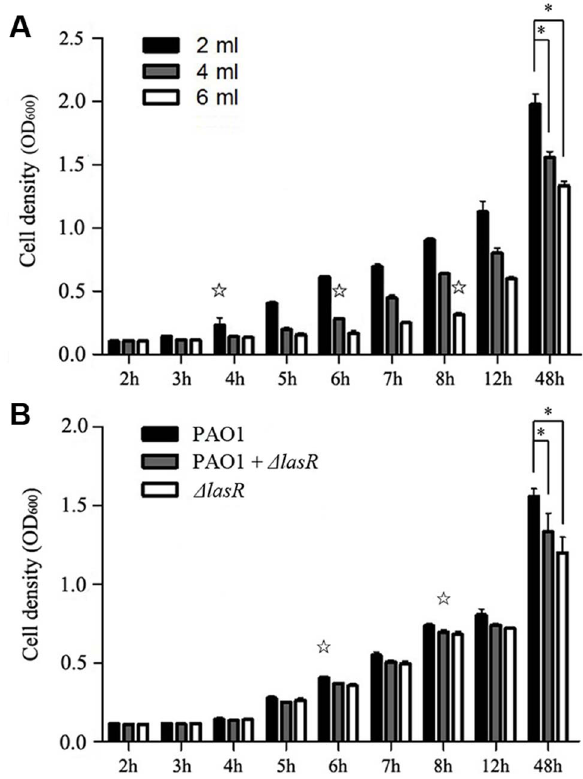
Figure 1. Cooperation activation was delayed due to the presence of lasR mutant. (A) The same amounts of wild type (WT) P. aeruginosa PAO1 were cultured in different volumes of LB broth medium. (B) 10 m l of overnight cultivated WT PAO1, 5 m l WT PAO1 + 5 m l PAO1- D lasR , and 10 m l PAO1- D lasR strains were independently cultured in the same volume of LB broth medium. Activation of cooperation ( q ) was determined by significantly increased expression of lasB gene. Data are means 6 SEM, and representative of three experiments. *, P , 0.05, one-way ANOVA (Tukey-Kramer post hoc).